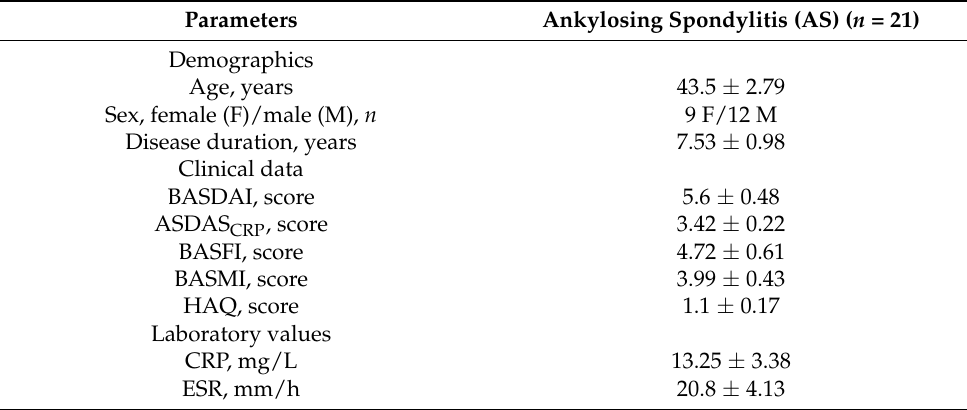
Table 1. Demographic and clinical characteristics of the